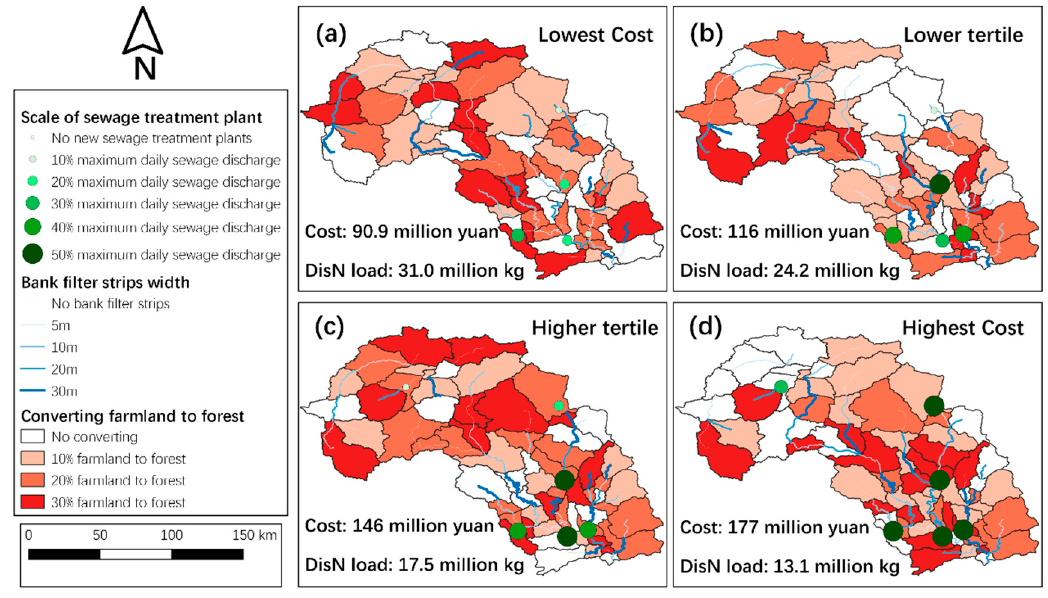
ff erent costs, as provided in Figure